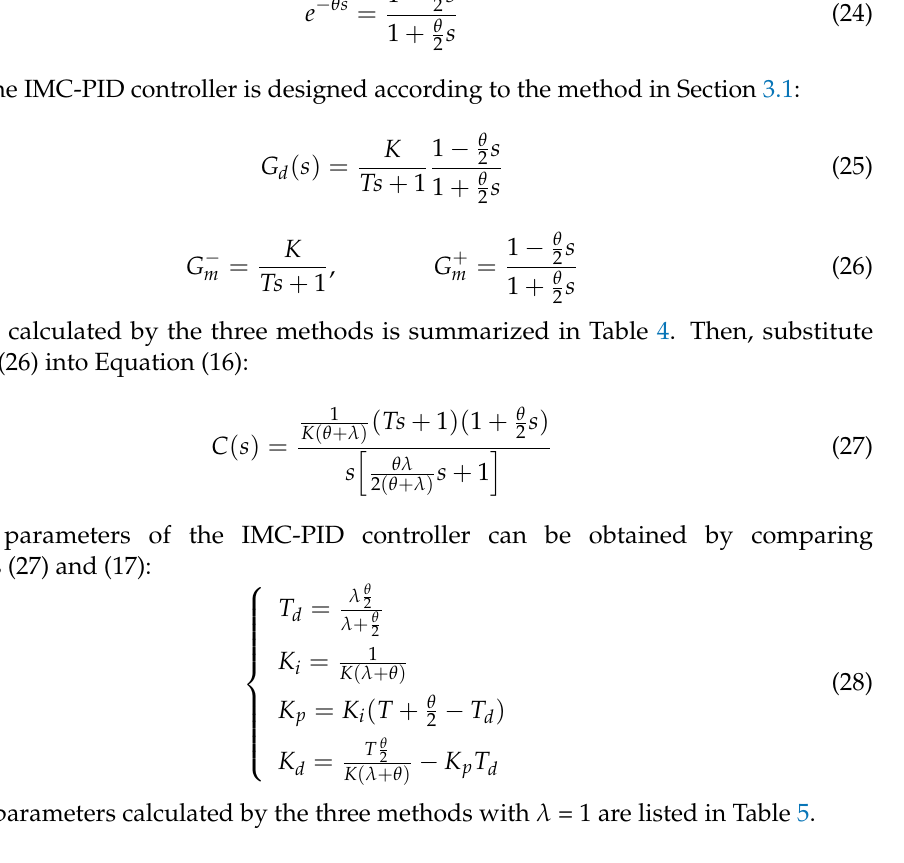
Table 5. IMC-PID controller parameters ( λ =